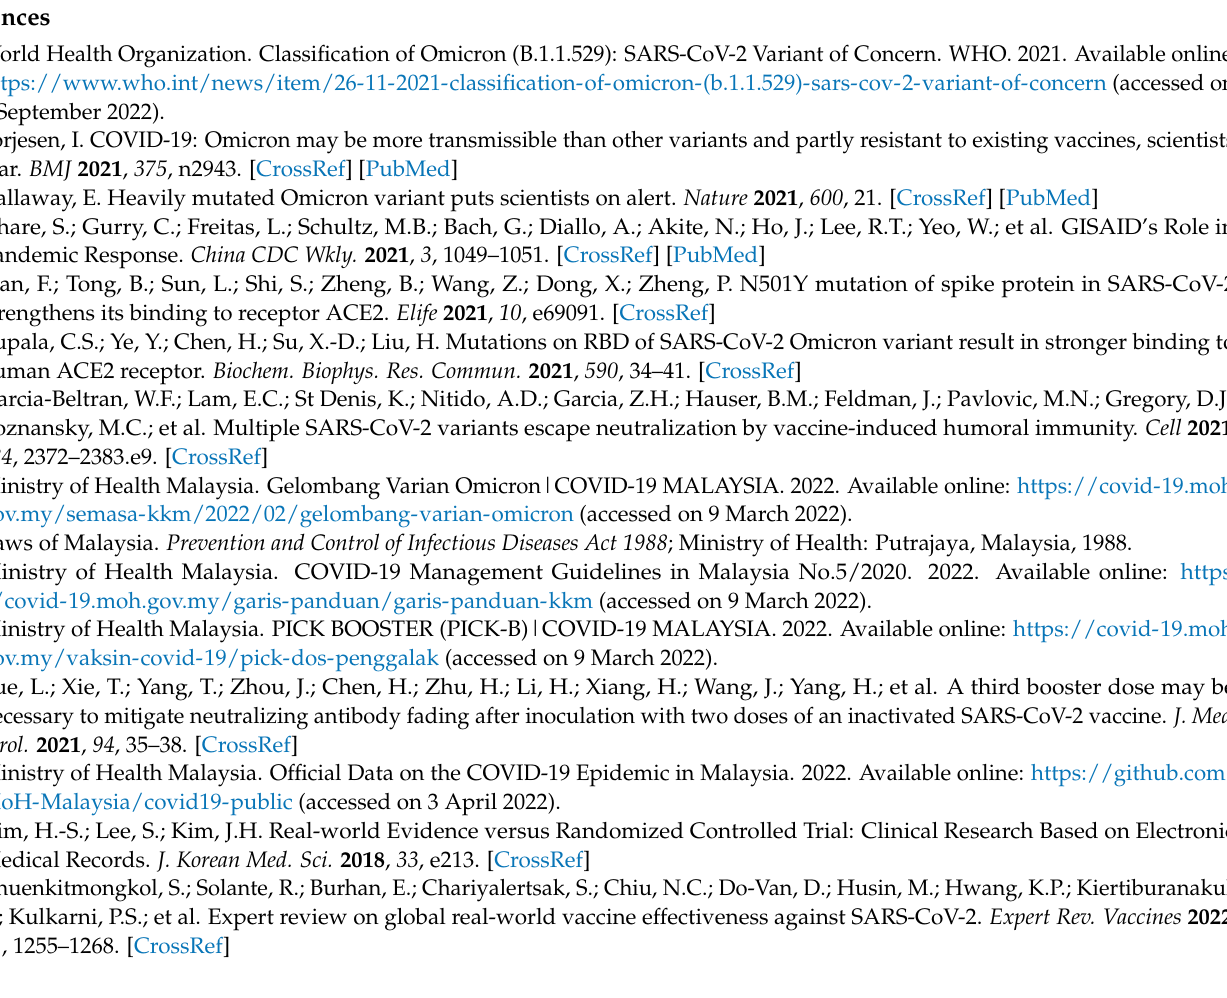
Percentages for the number of individuals are of the total population, while percentages for each characteristic are within the respective vaccination status group. Abbreviations: BNT162b2, Pfizer-BioNTech; CoronaVac, Sinovac; AZD1222,